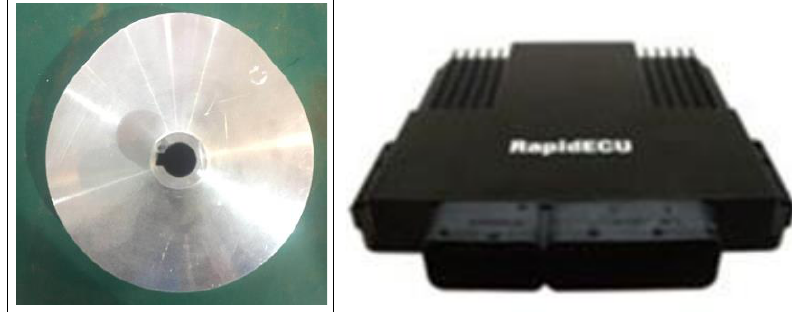
Figure 7. The cam for simulating road excitation and the RCP controller.